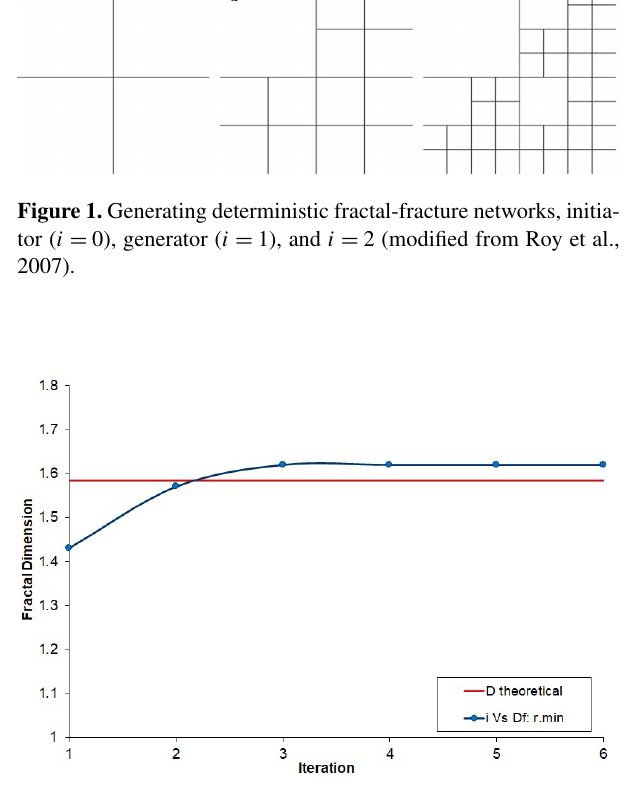
placed at the exact location (upper-left corner in this case) as in the